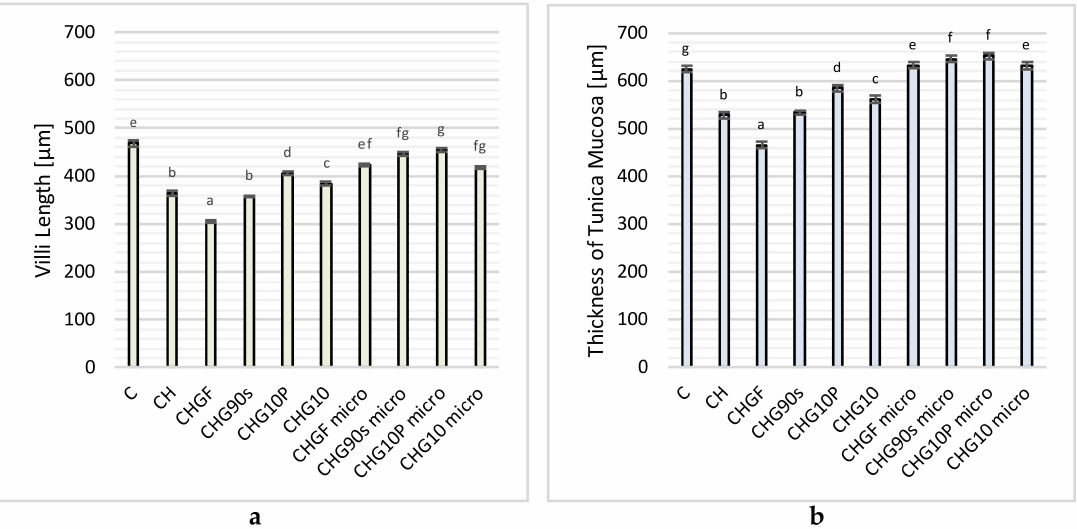
Figure 2. Influence of freeze-dried fresh and thermally processed garlic on villi length ( a ) and thickness of tunica mucosa ( b ) in rats fed control- and cholesterol-containing (1% of cholesterol) diet during the 28 day experiment. Values are means ± SD ( n = 6). Means in bars with different letters are significantly different ( p < 0.05), Tukey’s